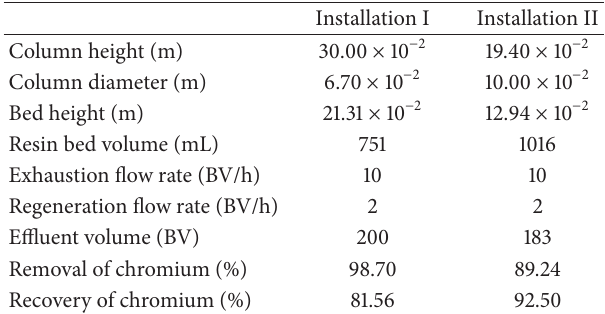
Table 3: The characteristics of the pilot